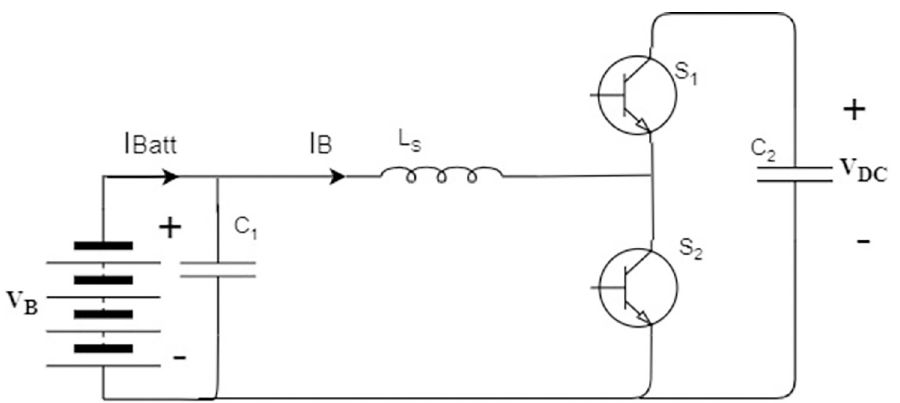
Fig 5. Bidirectional DC/DC converter for